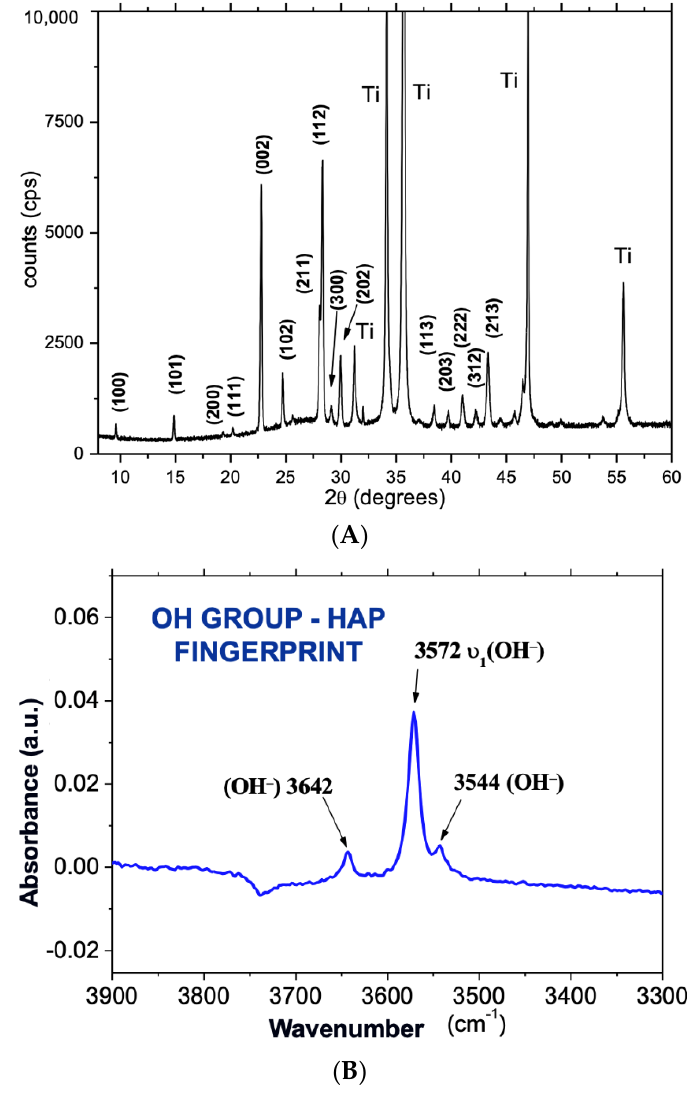
Figure 1. ( A ) XRD of the implant after the surface coating. The diffraction peaks show highly crys- talline hydroxyapatite with crystallites preferentially oriented along the axis c; ( B ) OH vibration bands in the FTIR spectrum of as-sputtered HA coatings for 180 min and 120 W RF power sputtering